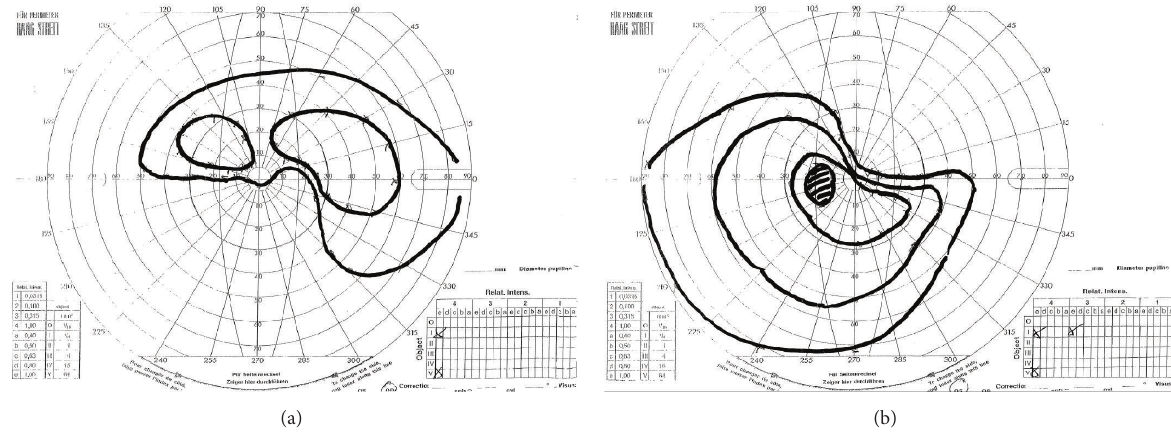
Figure 1: Goldmann perimetry. (a) Right eye, (b) left